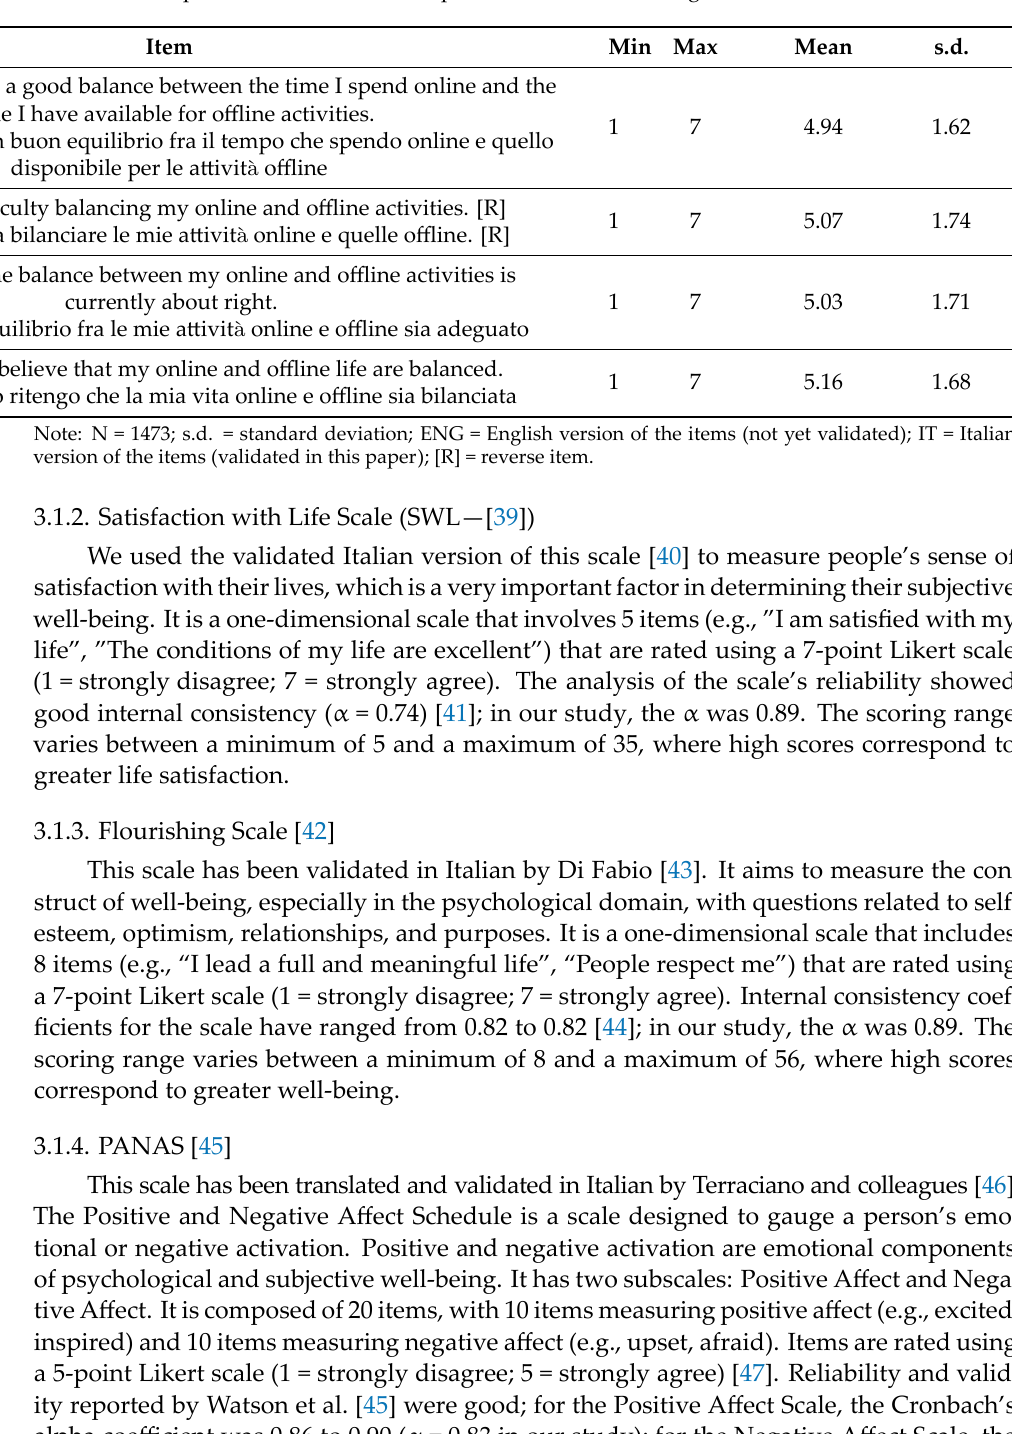
Table 1. Descriptive statistics of the item pool used to build the Digital Life Balance